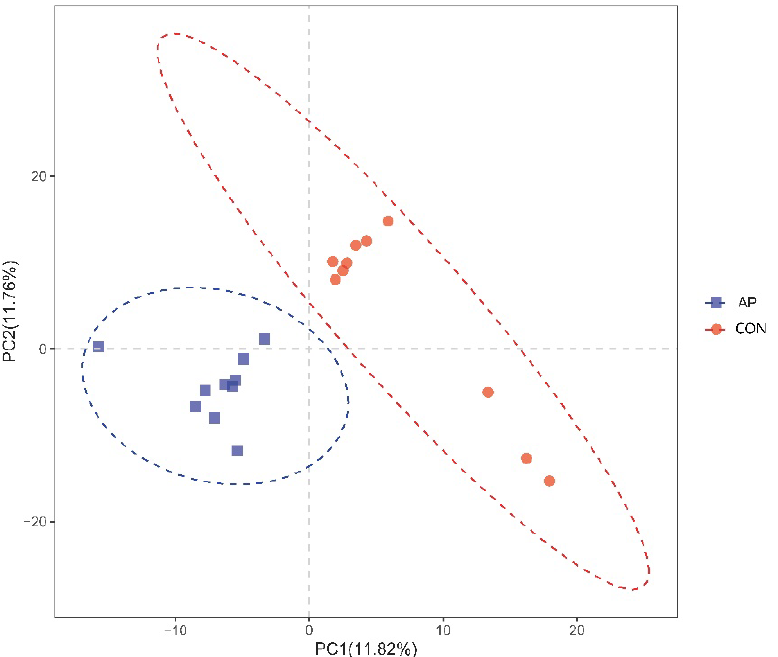
Figure 2. OTUs PLS-DA (Partial Least Squares Discrimination Analysis) of the bacterial community structure of the microbiome. Orange circle, the control group (CON); blue square, the apple pomace group (AP). Each point represents a sample.